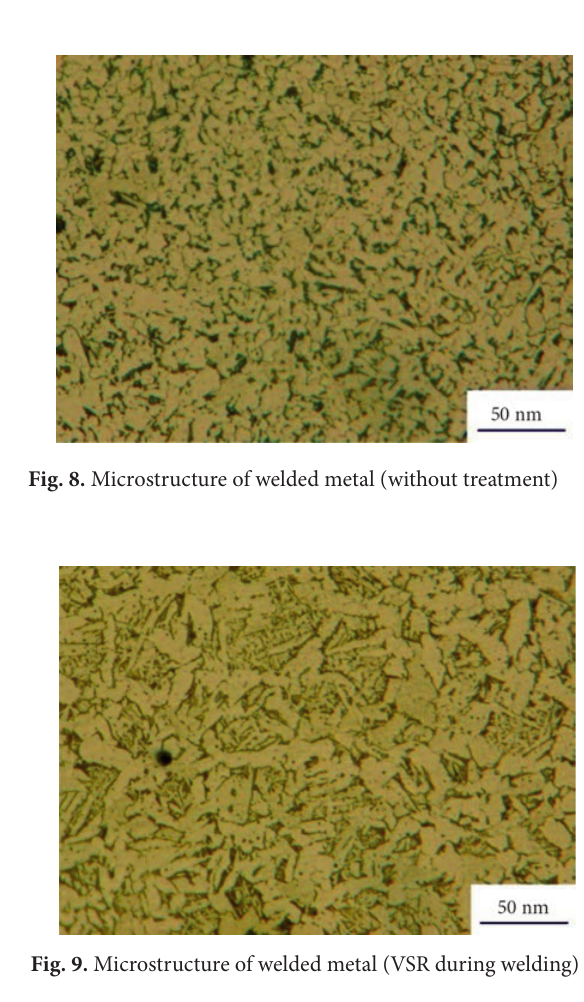
Fig. 7. The impact strength test results